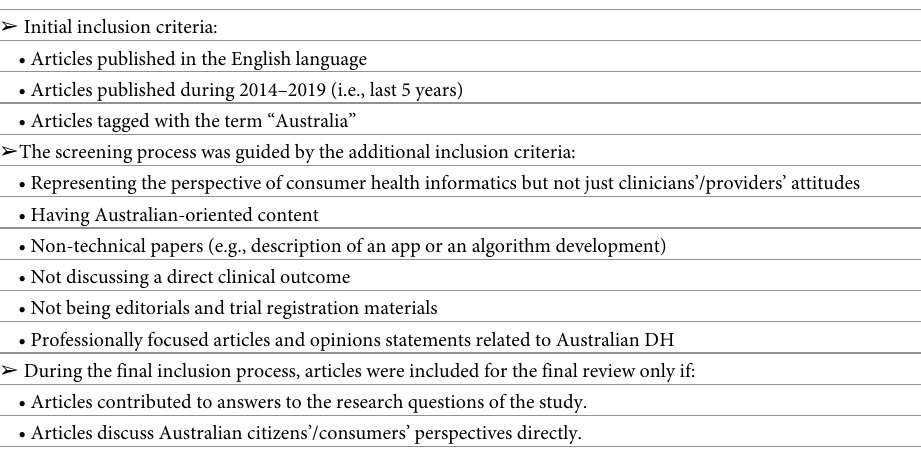
Table 1. Selection